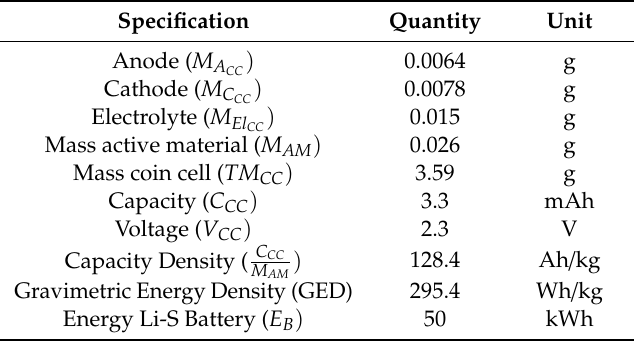
Table 2. Inventory data to calculate Scaling Factor.